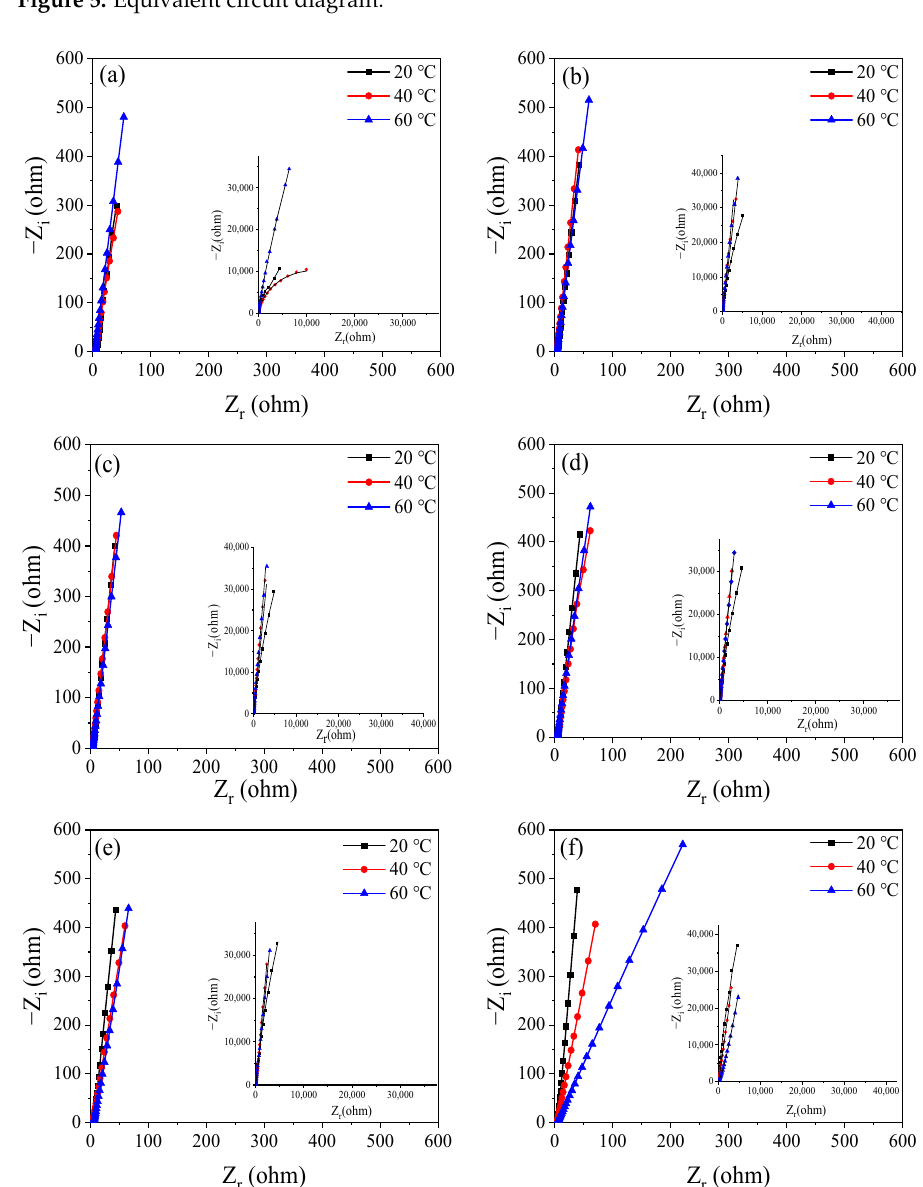
Figure 6. Nyquist plots of Q235 steel passivated for ( a ) 0.5 h, ( b ) 6 h, ( c ) 12 h, ( d ) 24 h, ( e ) 48 h, and ( f ) 240 h.